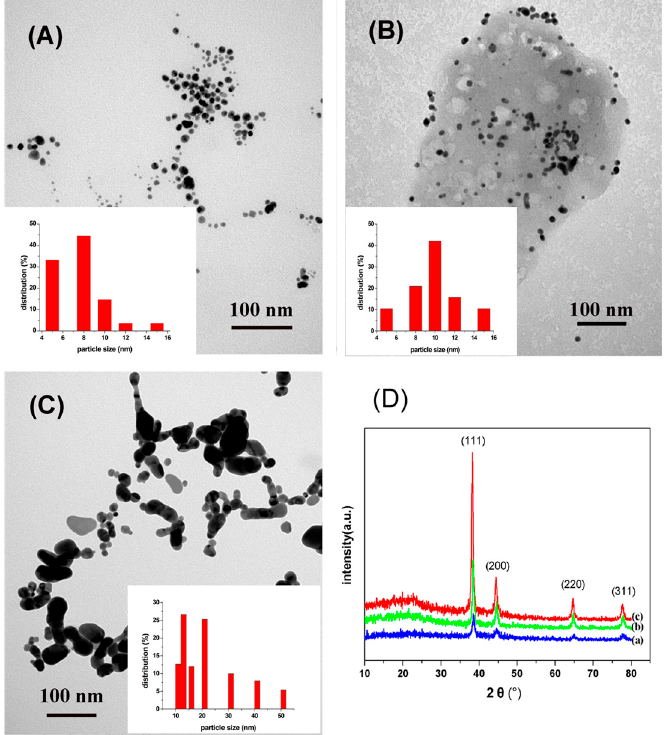
Figure 2. ( A – C ) TEM images of AuNPs prepared using 0.25, 1.0, 3.5 mM of HAuCl 4 , respectively; ( D ) XRD patterns of AuNPs prepared using different HAuCl 4 concentrations of 0.25 ( a ); 1.0 ( b ); 3.5 ( c ) mM, respectively. The inset is the corresponding particle size analysis histogram of the gold